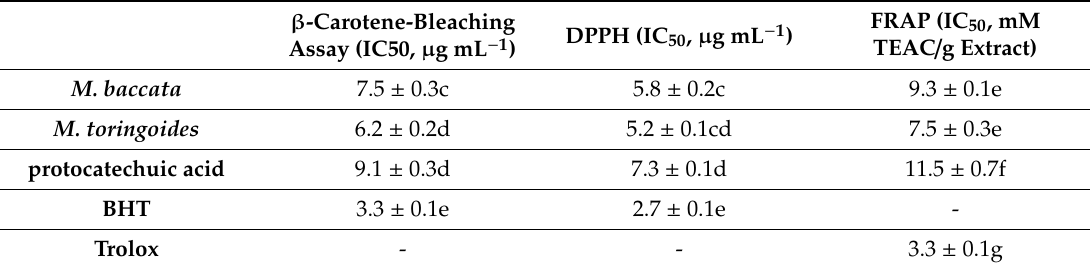
Table 2. β -carotene bleaching, DPPH, and FRAP of Malus baccata and Malus toringoides bark extracts and protocatechuic acid.